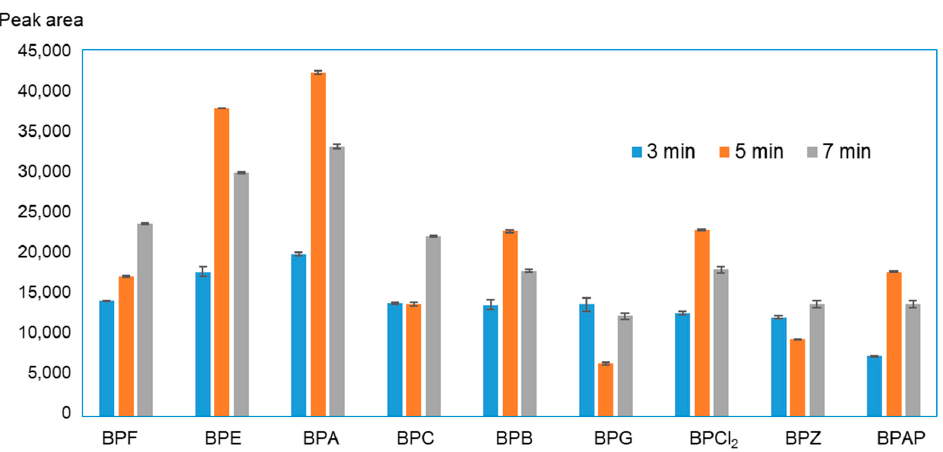
Figure 3. Influence of emulsification time on BP extraction efficiency.